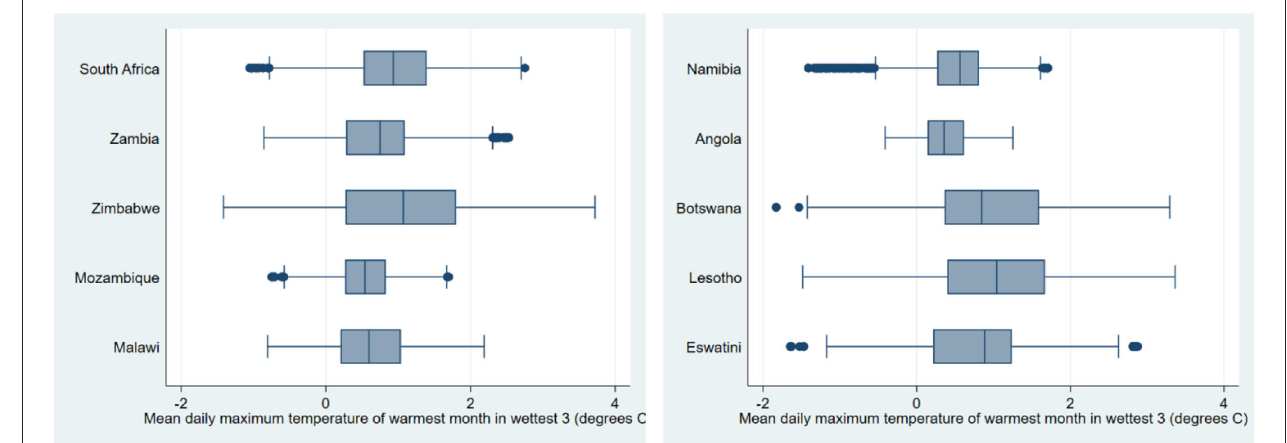
FIGURE 8 | Variation in historical mean daily maximum temperature for the warmest month of the wettest 3 months by country from detrended monthly data, 1948–2016. Source: Authors’ calculations based on Princeton Global Forcings, version 3 [2018, based on Sheffield et al. (2006)]. For box and whisker plots, the box is bounded by the 25th and 75th percentiles, with the mid-line inside the box showing the median. The length from the 25th to the 75th percentile is called the inter-quartile range (IQR). The endpoint of the whiskers is the point that just lies within a distance of 1.5 times the IQR from the ends of the boxes. Any point beyond the whiskers is plotted individually.